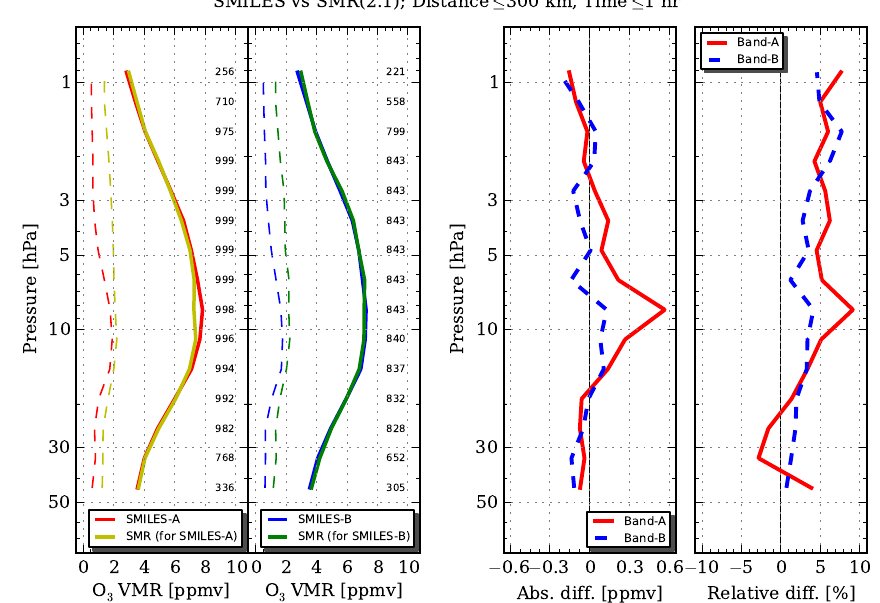
Fig. 20. Comparison between SMILES Band-A and SMR. Same key as in Fig. 16.